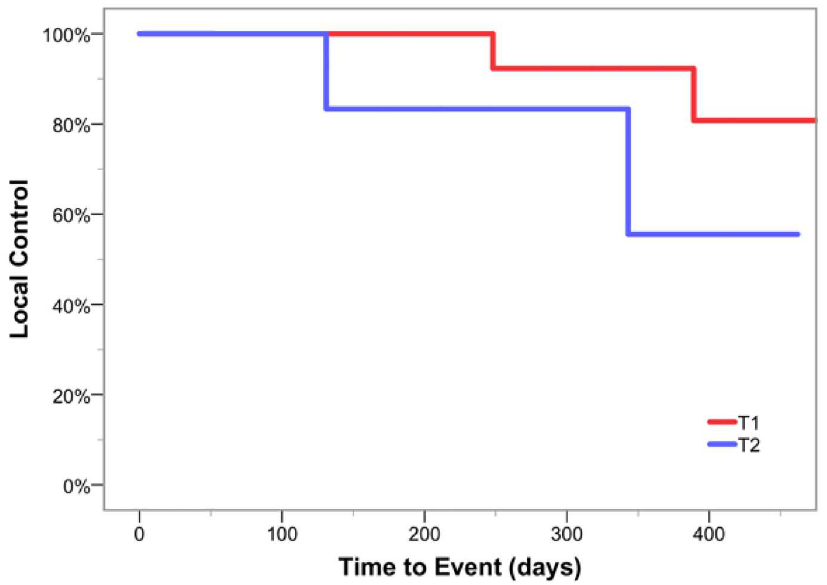
Fig 3. Estimated local recurrencefree survival for cT1 and cT2